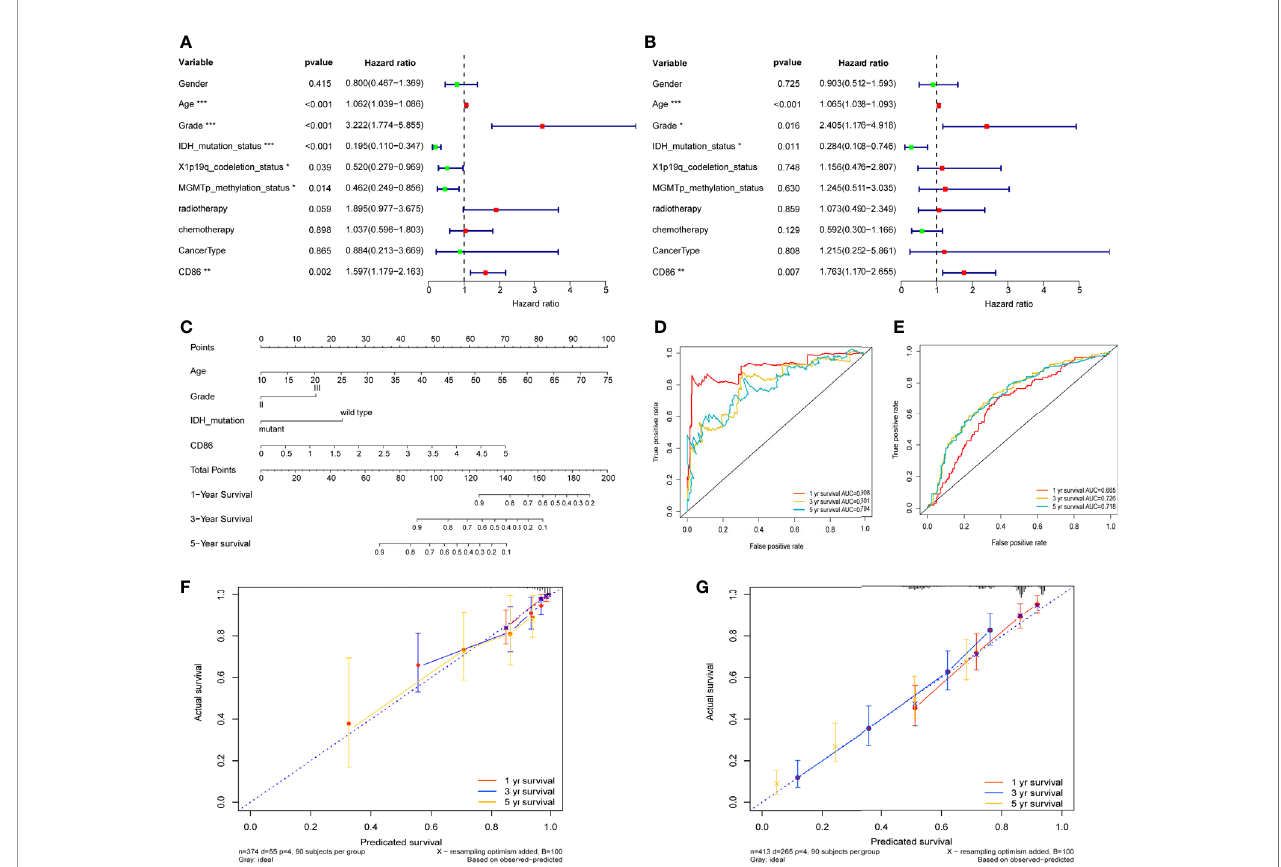
FIGURE 7 | Development and validation of a Nomogram. Univariate Cox regression (A) and Multivariate Cox regression (B) with CD86 expression, demographic and clinicopathological factors; Red dots represent risk factor (HRs>1), while green dots represent protective factor (HRs<1). *P<0.05, **P<0.01, ***P<0.001. (C) Nomogram with independent prognostic factors. ROC curve analysis at 1 year, 3years, and 5 years using TCGA dataset (D) and the CGGA dataset (E) . Calibration plot at 1 year, 3years, and 5 years in TCGA (F) and the CGGA (G)